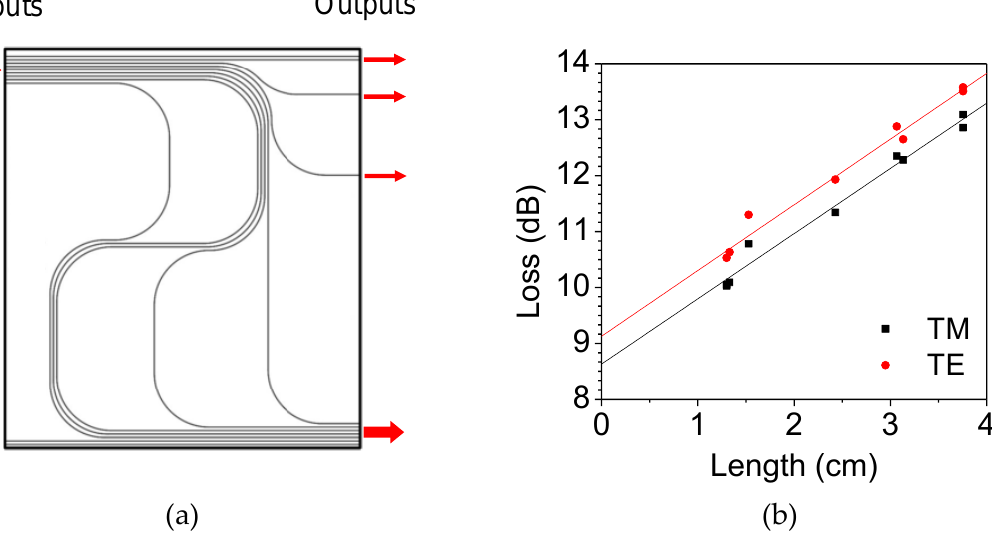
Figure 5. ( a ) Photomask layout of the waveguide patterns to measure the propagation loss, the bending loss, and the coupling loss of the fabricated waveguide. ( b ) The measured insertion losses plotted as a function of waveguide length of each waveguide pattern. From these results, the values of propagation, bending, and coupling losses were found by using the least-squares method from the overdetermined linear system.